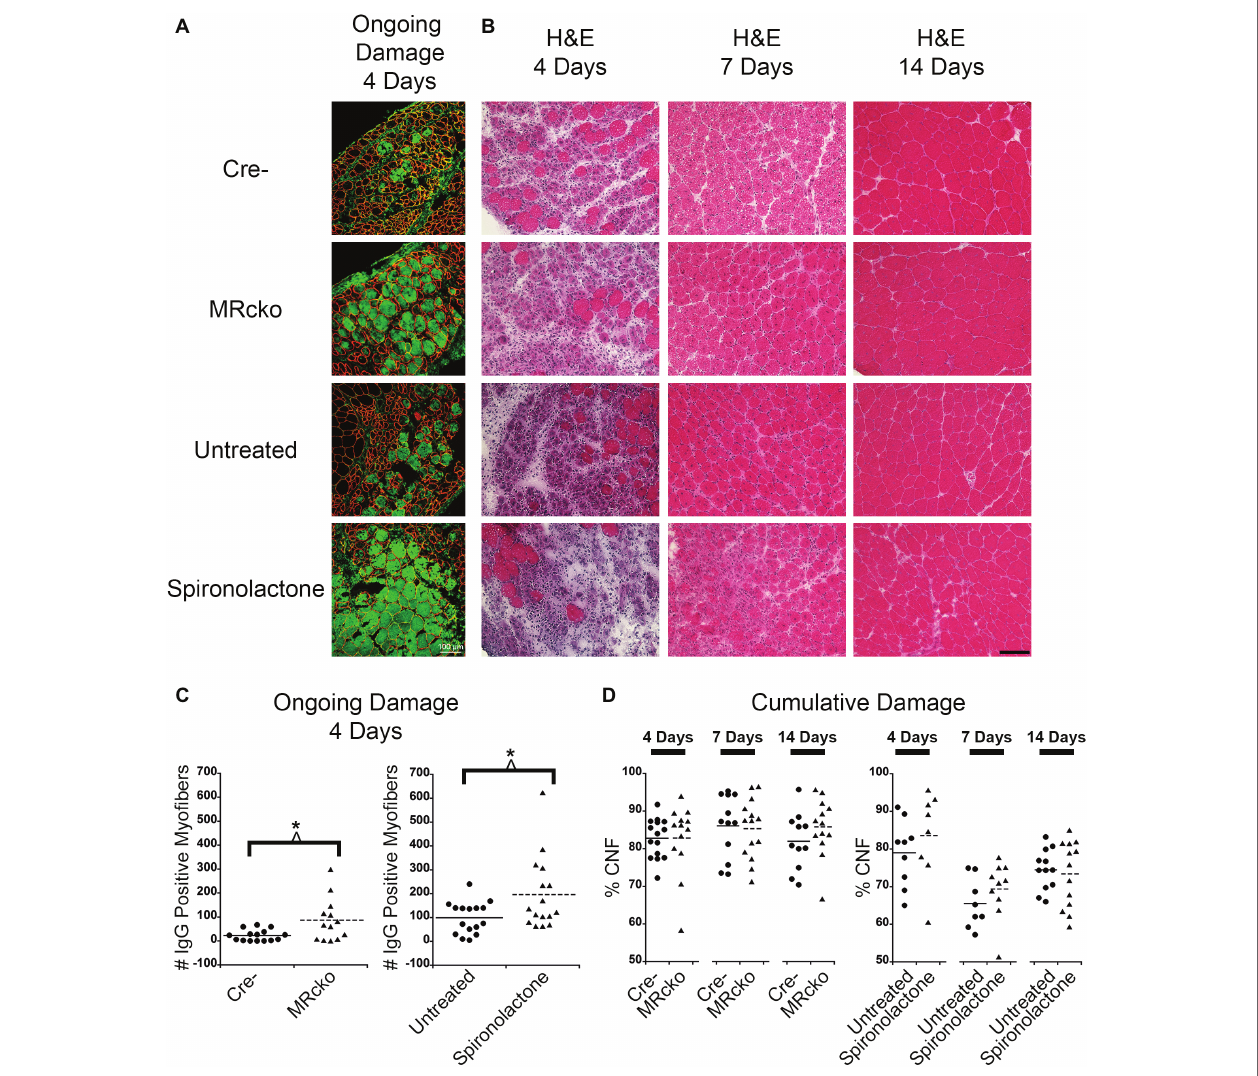
FIGURE 3 | Increased percentages of degenerating myofibers in both MRcko and MR antagonist-treated wild-type mice. (A) Representative confocal images of IgG and laminin staining of 4 days post-injury tibialis anterior (TA) sections. Scale bar = 100 μ m. (B) Representative TA sections at 4, 7, and 14 days post-injury stained with hematoxylin and eosin. Scale bar = 100 μ m. (C) Dot plots showing number of IgG positive fibers at 4 days post-injury for MRcko and Cre − littermates ( n = 15 Cre − , and 13 MRcko) and spironolactone treated and untreated wild-type littermate mice ( n = 16 untreated, and 16 spironolactone). Means are shown by lines for each group in the dot plot. (D) Dot plots showing percent of myofibers with centralized nuclei in MRcko mice and control littermates at 4 ( n = 15 Cre − , and 13 MRcko), 7 ( n = 12 Cre − , and 14 MRcko), and 14 ( n = 11 Cre − , and 13 MRcko) days post-injury and spironolactone-treated mice at 4 ( n = 9 untreated, and 8 spironolactone), 7 ( n = 8 untreated, and 10 spironolactone), and 14 ( n = 12 untreated, and 13 spironolactone) days post-injury. Means are shown by lines for each group. H & E, hematoxylin and eosin; data were analyzed using a Student’s t -test; * p ≤